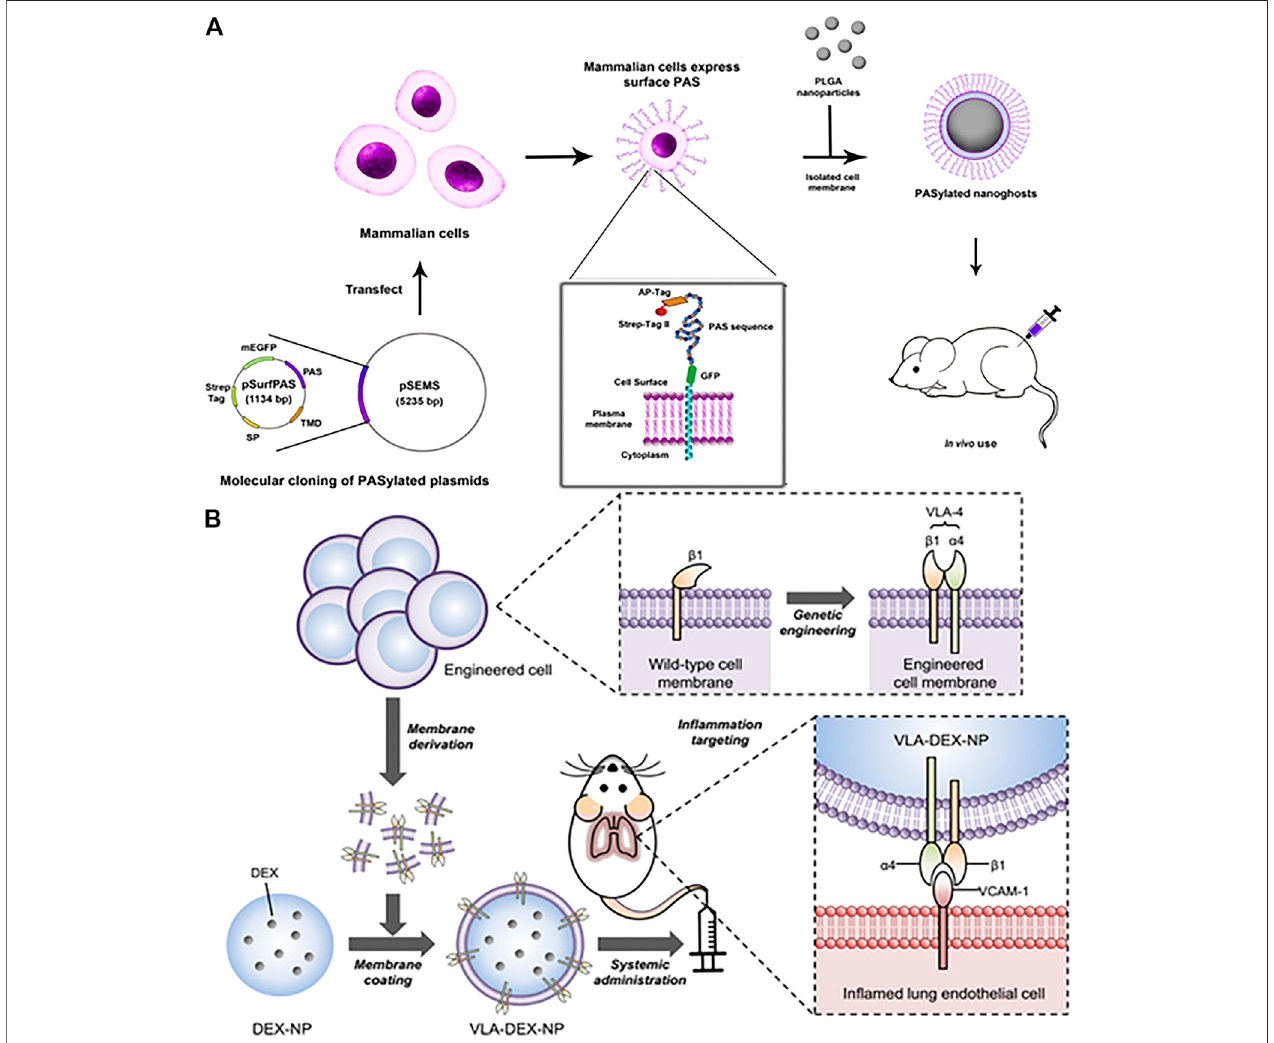
FIGURE 5 | (A) Illustration of functionalized PASylated nanoghosts obtained by plasmid transfection. (Reproduced with permission from Krishnamurthy et al. (2019)). (B) Schematic illustration of genetically engineered cell membrane – coated nanoparticles for targeted DEX to in fl amed lungs. (Reproduced with permission from Park et al.